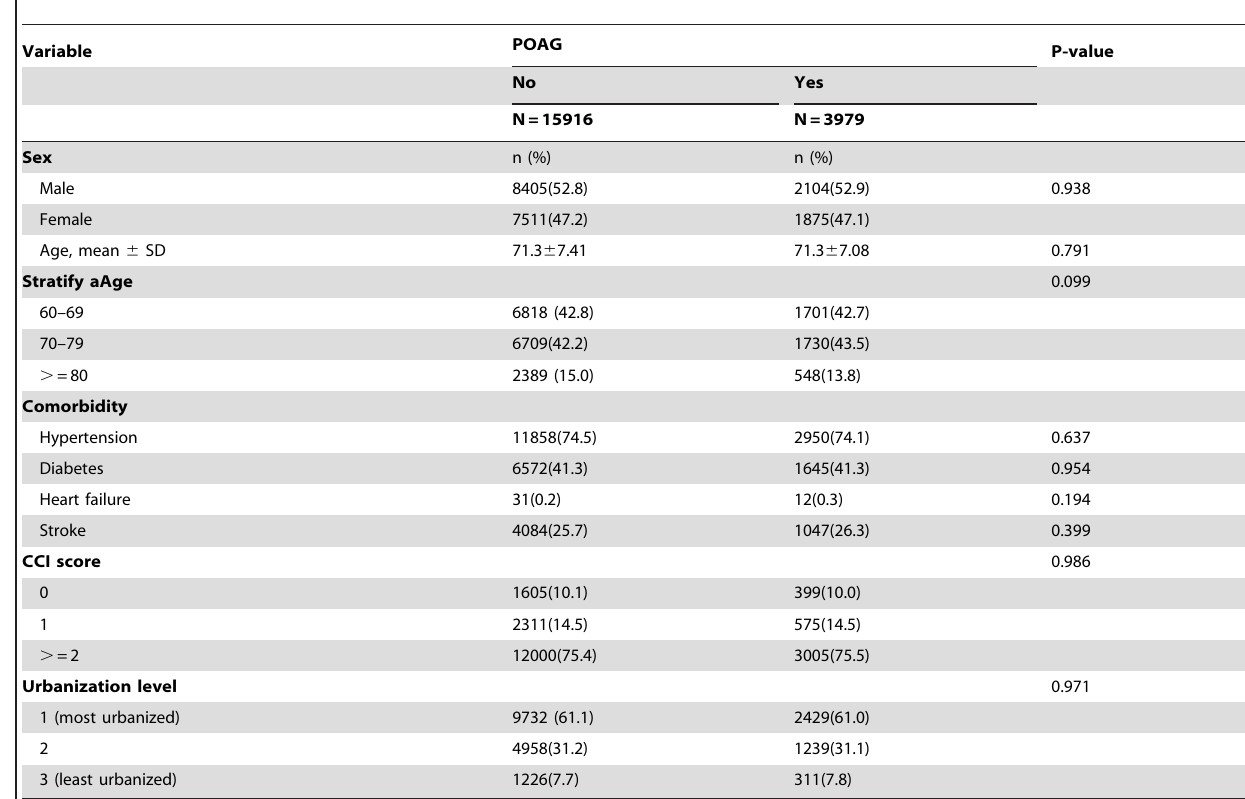
Table 1. Demographic characteristics and comorbidities in cohorts with and without POAG.